Question: Does the figure show an increasing or a decreasing trend?
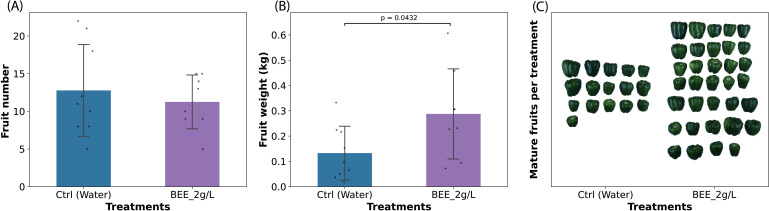
Answer: increasing